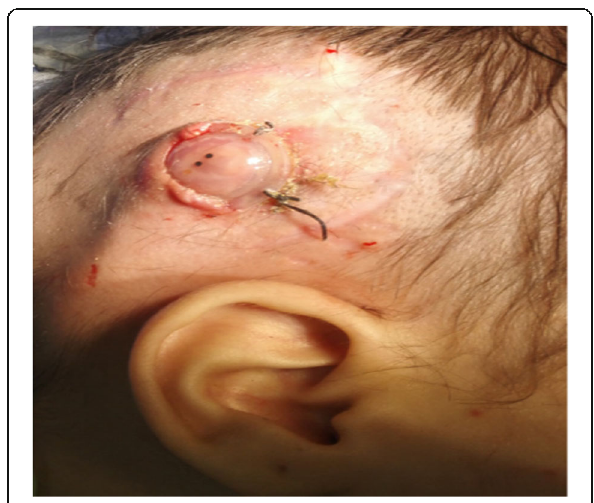
Fig. 2 Photograph of a 6-month-old infant showing complete ex- posure of the shunt reservoir